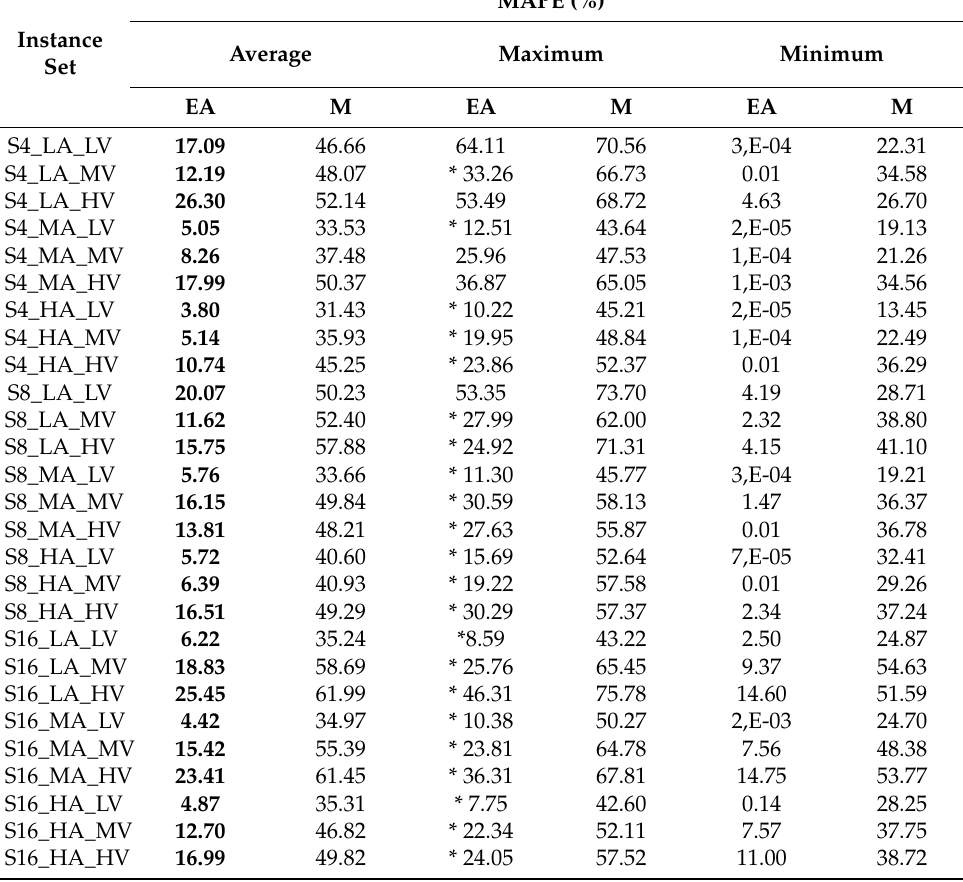
Table 4. Average, maximum, and minimum MAPE (%) value obtained by the evolutionary algorithm (EA) and the Motrol method (M) for each instance set. Bold values indicate better average MAPE (%) values. The symbol * indicates that the maximum MAPE (%) value reached by EA is lower than the minimum MAPE (%) value reached by